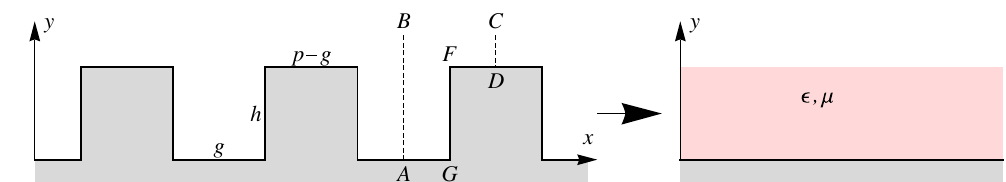
FIG. 2. Corrugated surface and the equivalent dielectric-magnetic layer that replaces it in the effective boundary